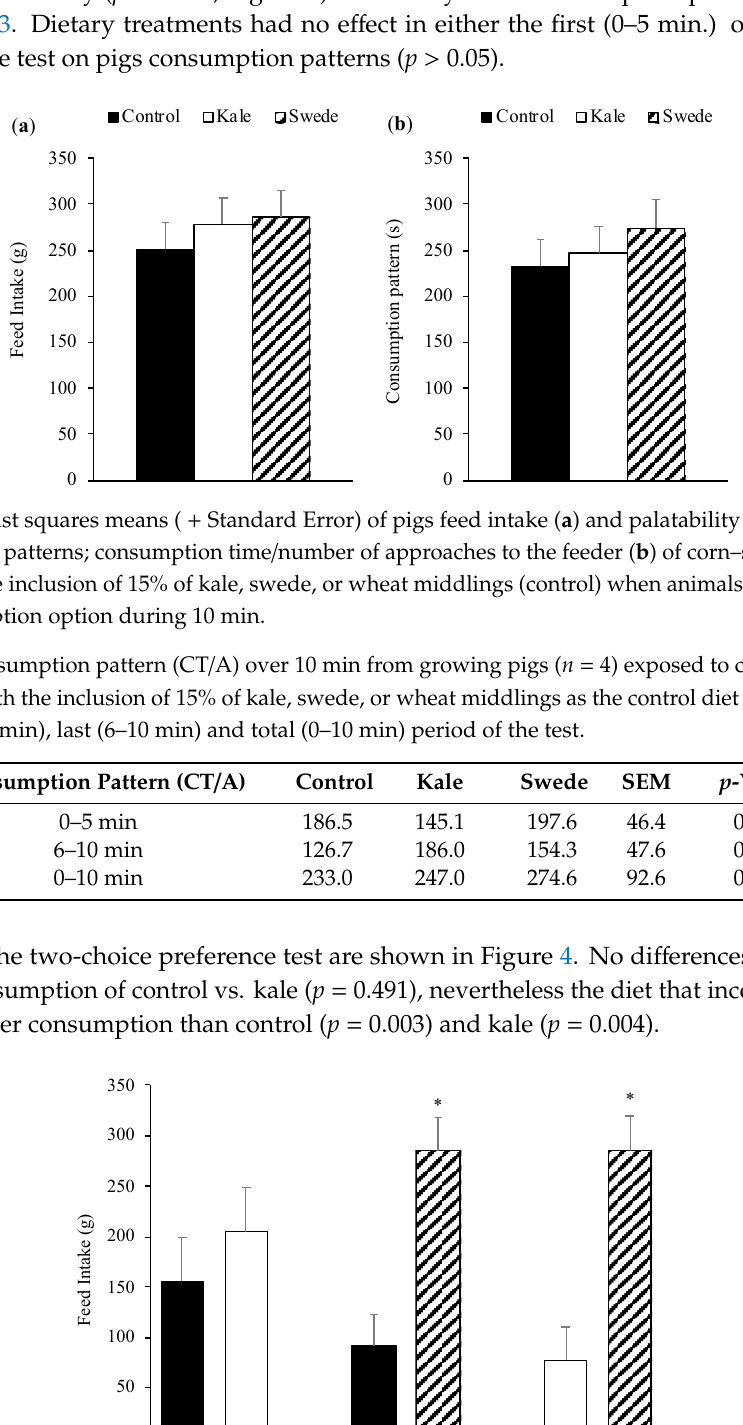
Figure 2. Pigs’ feed intake (g) of corn–soybean base diets (least squares means + standard error) with the inclusion of 15% of forage rape, turnip, or wheat middlings (control) when animals were offered a two-feeder preference test during 10 min.